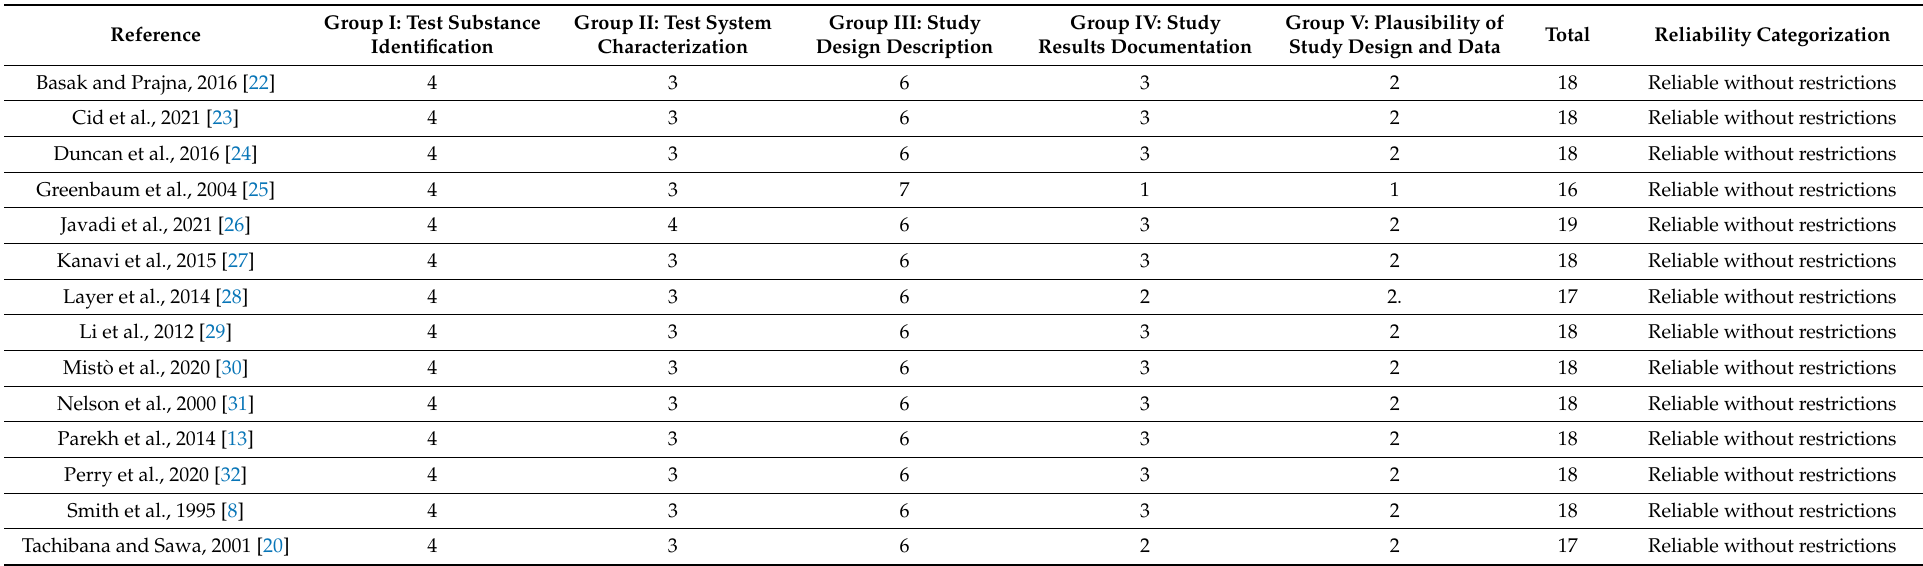
Table 3. Quality assessment according to the ToxRTool